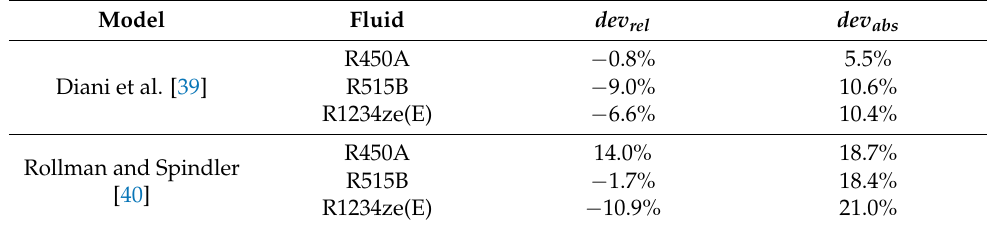
Table 4. Accuracy of implemented correlations for heat transfer coefficient.